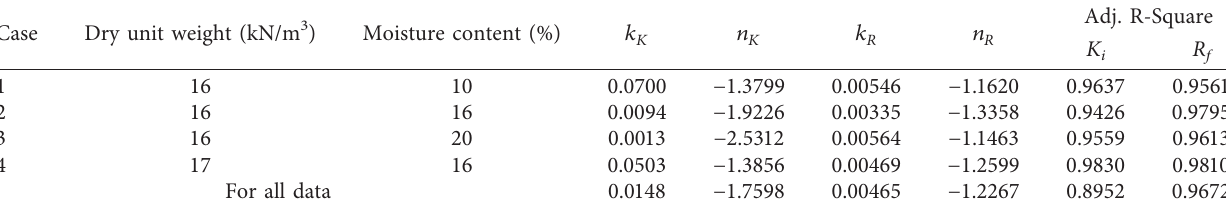
Table 4: Parameters for describing nonlinear spring of